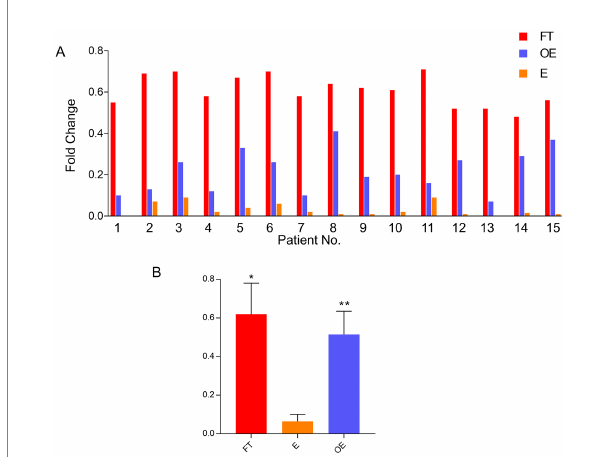
FIGURE 1 FOLR1 gene expression level in paired tubal, endometrial, and ovarian endometriosis samples. Comparisons of mRNA expression levels in the fallopian tube, the endometrium, and the foci of endometriosis by quantitative PCR in 15 individual paired cases (A) and the pooled data (B) . FOLR1 levels in fallopian tube (FT) and ovarian endometriosis (OE) were similar, but both were higher than the observed FOLR1 level in the endometrium (E) [* p = 0.176 (FT vs. OE) and ** p = 0.0018 (E vs. OE)]. FT: fallopian tube; E: endometrium; OE: ovarian